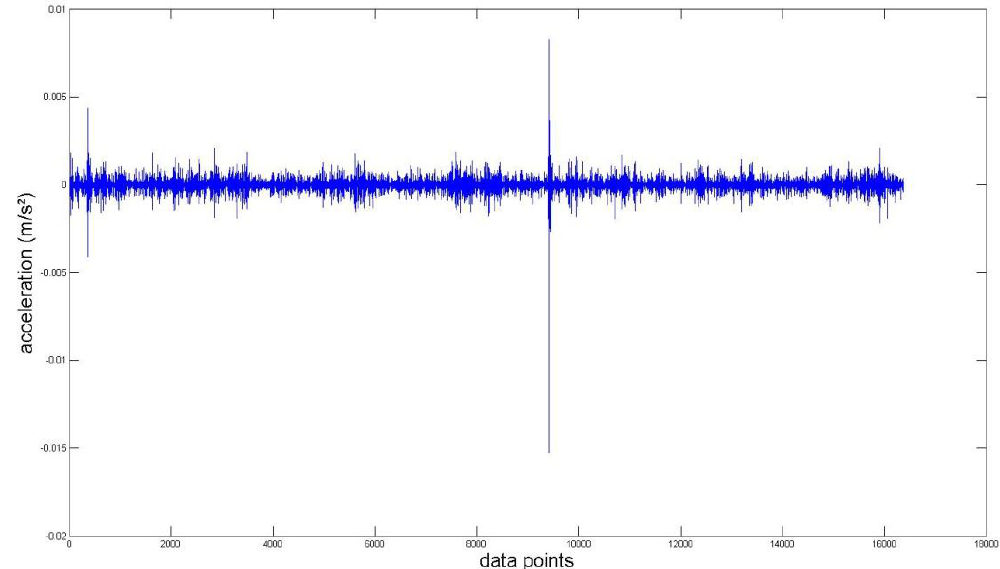
Figure 10. Vibration data points after applying the TKEO first, and then MED signal processing on a damaged bearing (Case